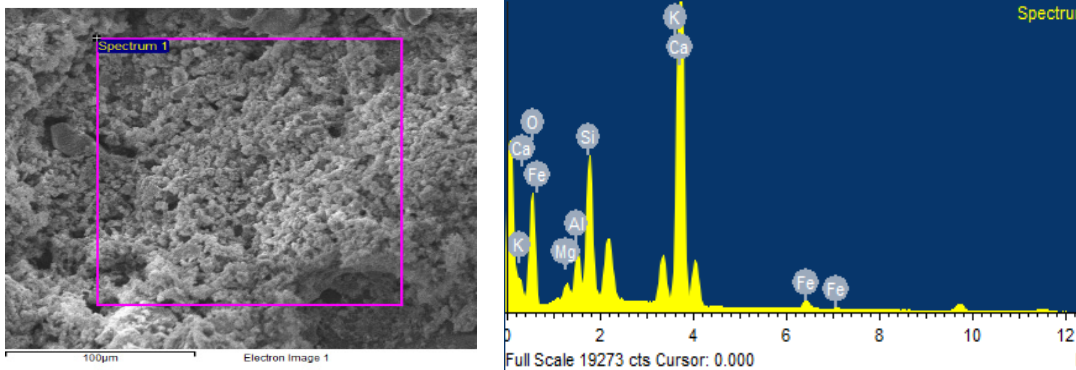
Figure 12. EDS of earth+bio mortar. Table 4. EDS analysis of earth-based mortars with and without biostabiliser.